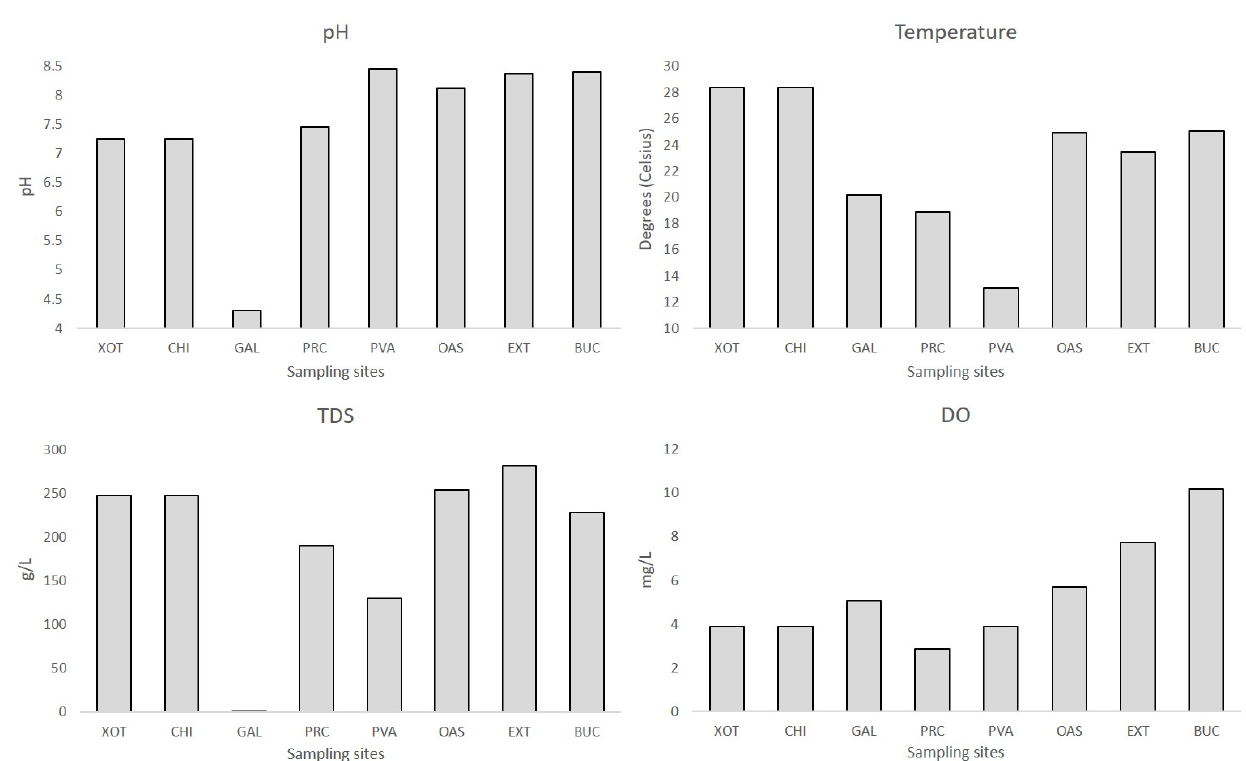
FIGURE 2 | Physicochemical parameters of water in each study site in central Mexico: temperature (°C), TDS= Total dissolved solids (g/L) and DO= Dissolved oxygen (mg/L). XOT = El Xote; CHI = El Charco del Ingenio; GAL = Los Galvanes; PRC = Presa del Carmen; PVA = Paso de Vaqueros; OAS = Oasis; EXT = Extoraz; BUC =